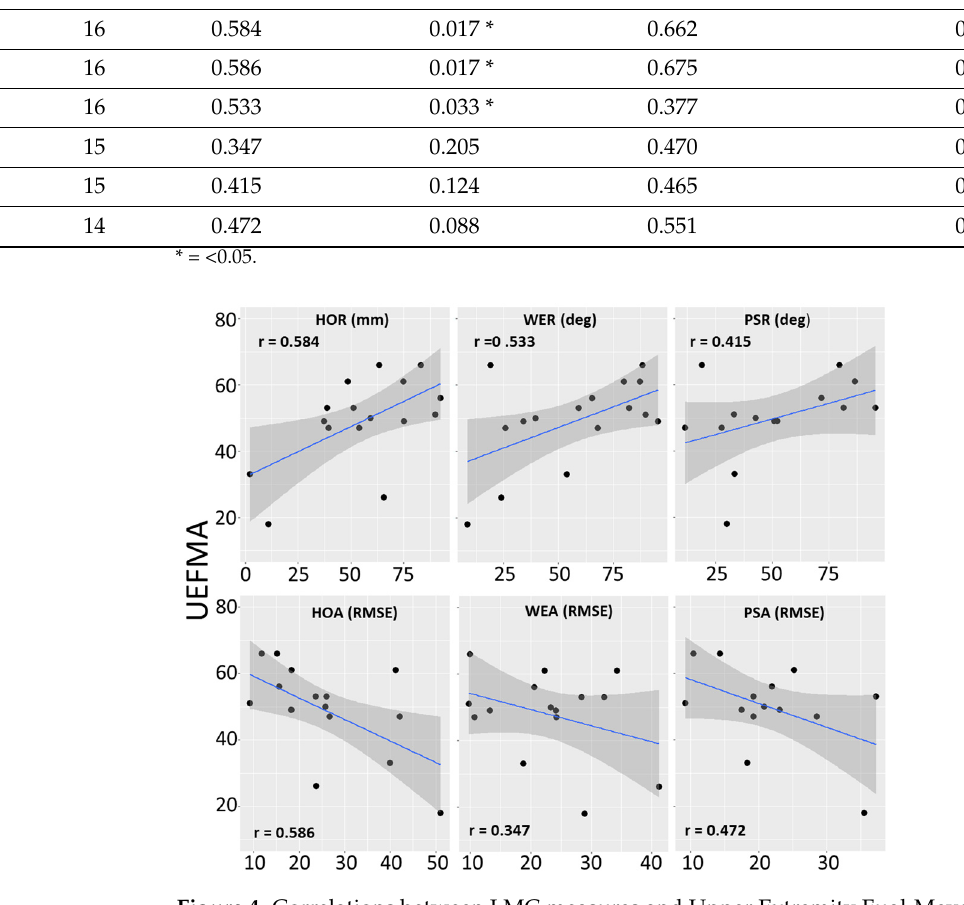
Figure 4. Correlations between LMC measures and Upper Extremity Fugl-Meyer